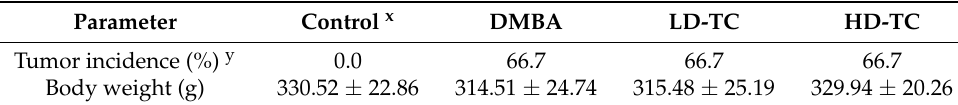
Table 2. Effects of theacrine on tumor incidence and body